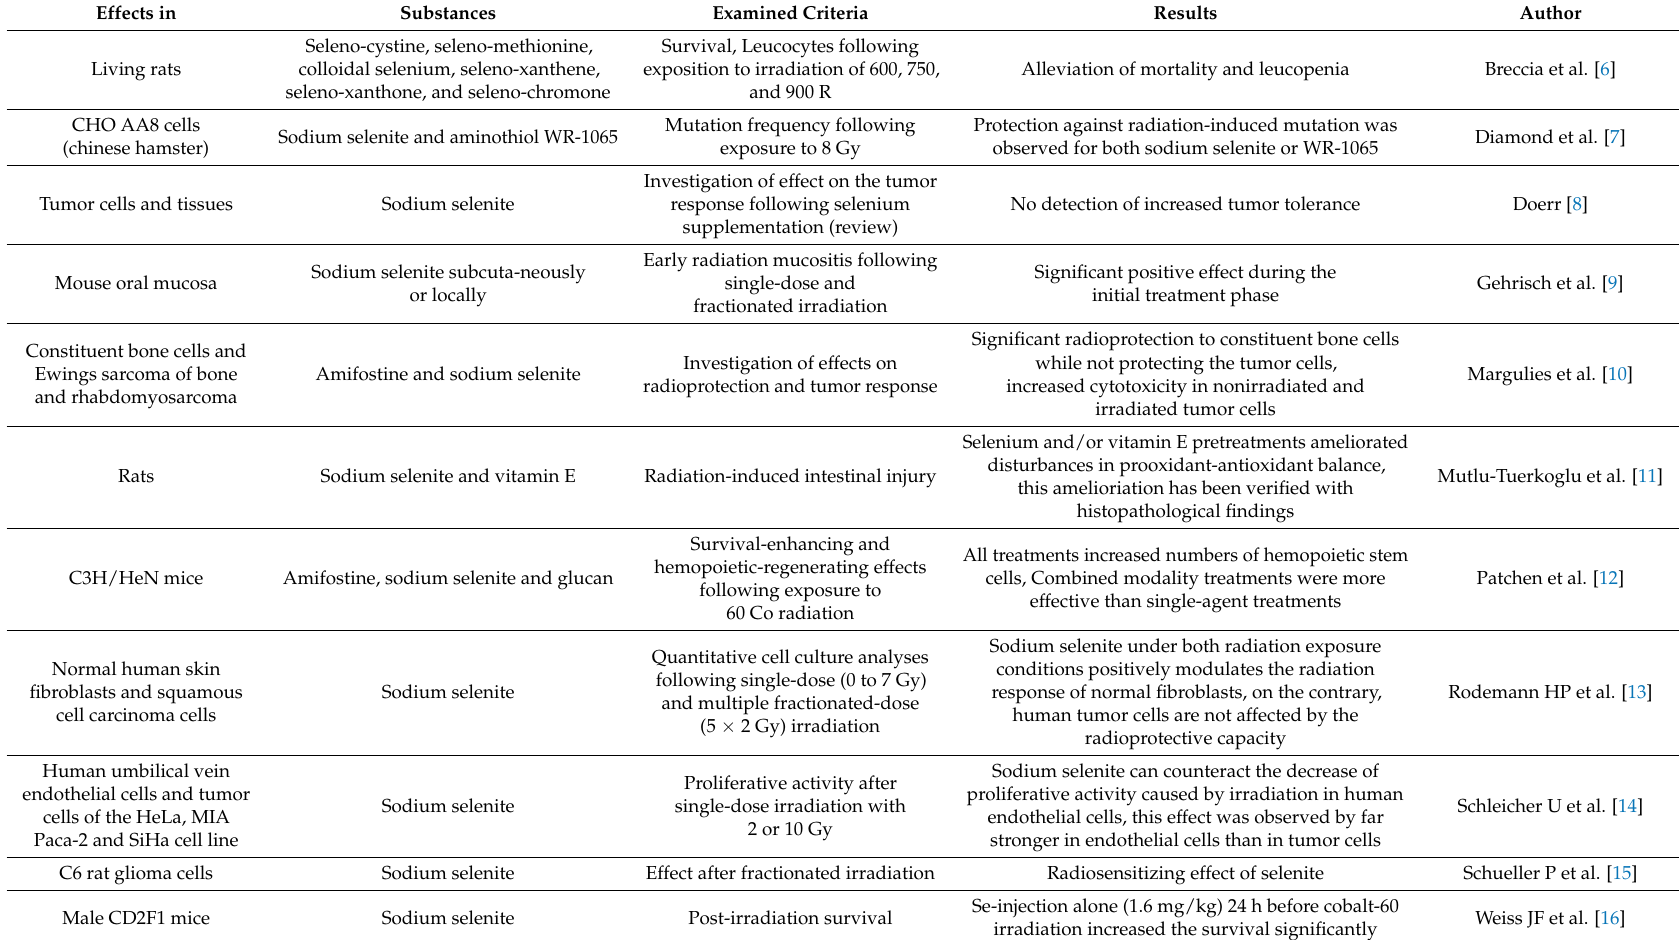
Table 1. Experimental evidence from preclinical and human studies on Se-use as an